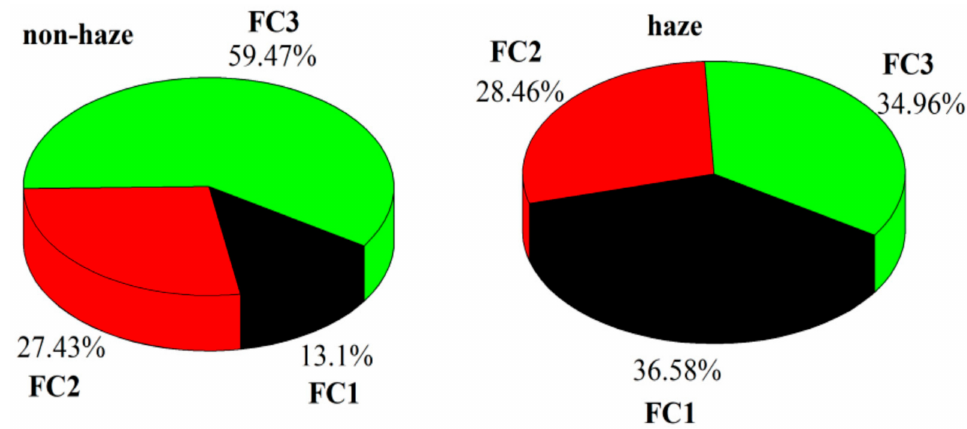
Figure 10. Contribution ratios of distinct sources on haze and non-haze